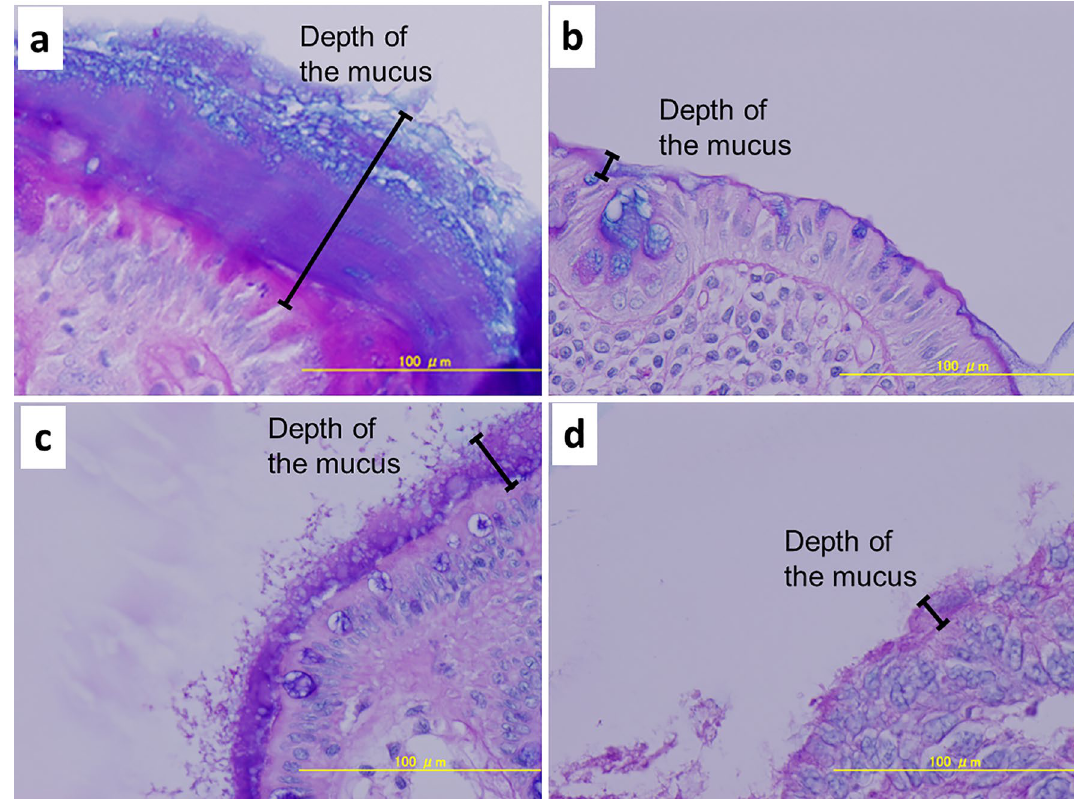
Figure 7. Measurement of the depth of mucus under microscopy using samples prepared by Carnoy fixation and staining with Alcian blue–periodic acid Schiff, ( a ) Non-cancerous lesion before washing, ( b ) Non-cancerous lesion after washing, ( c ) Cancer tissue before washing, and ( d ) Cancer tissue after